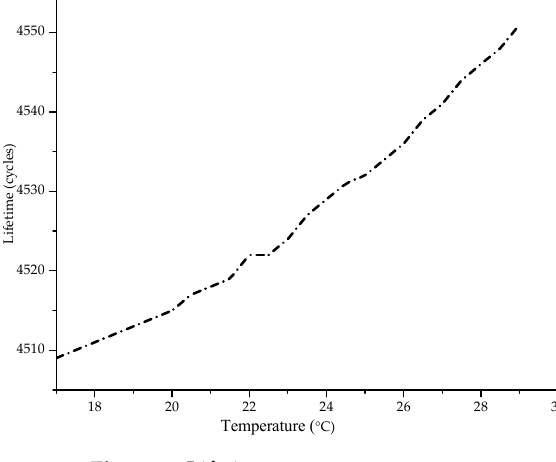
Figure 9. Lifetime versus temperature.